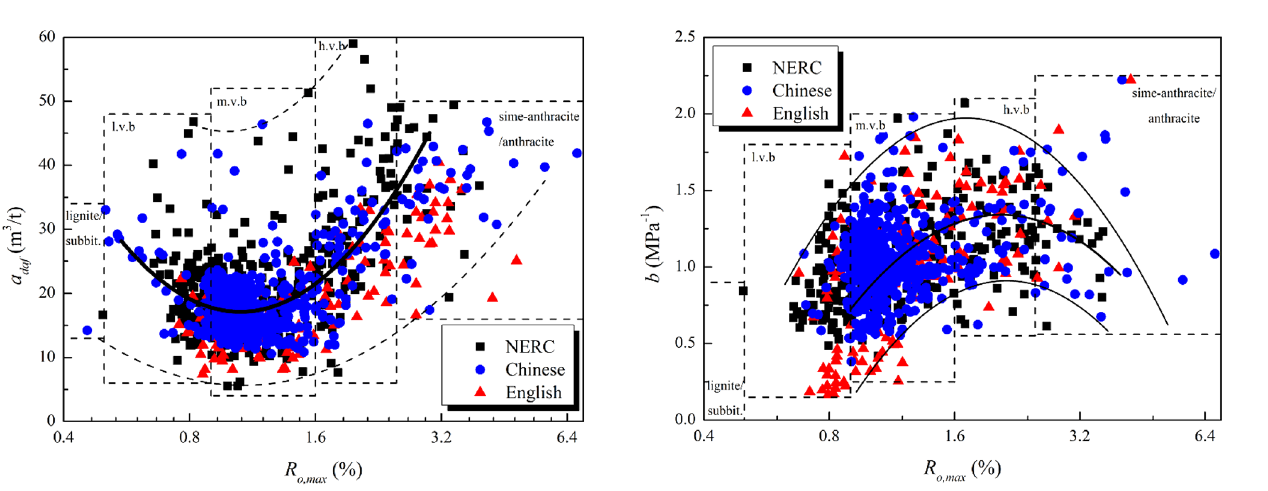
Fig. 1 Value of adsorption constant a daf versus vitrinite reflectance R o ; max . (Data size: NERC-290, Chinese (Zhang and Yang 1999; Fu et al. 2002; Zhang et al. 2004; Fu et al. 2005; Su et al. 2005; Su et al. 2006; Chen et al. 2008; Fu et al. 2008; Zhang and Sang 2008; Wang et al. 2008; Yu et al. 2008a; Chen et al. 2008; Jiang 2009; Zhang and Sang 2009; Yang et al. 2009; Ren 2010; Tian et al. 2010; Zhang et al. 2011; Zhang Jun-fan and Liang Wen-qing 2011; Zheng 2012; Gao 2012; Ma et al. 2014; Zhang et al. 2014)-173; English(Joubert et al. 1973; Yalc¸in and Durucan 1991; Beamish and O’Donnell 1992; DeGance et al. 1993; Chaback et al. 1996; Bustin and Clarkson 1998; Nodzen´ski 1998; Faiz et al. 2007a, b; Yu et al. 2008a, b, c; Xiao and Wang 2011)-103)